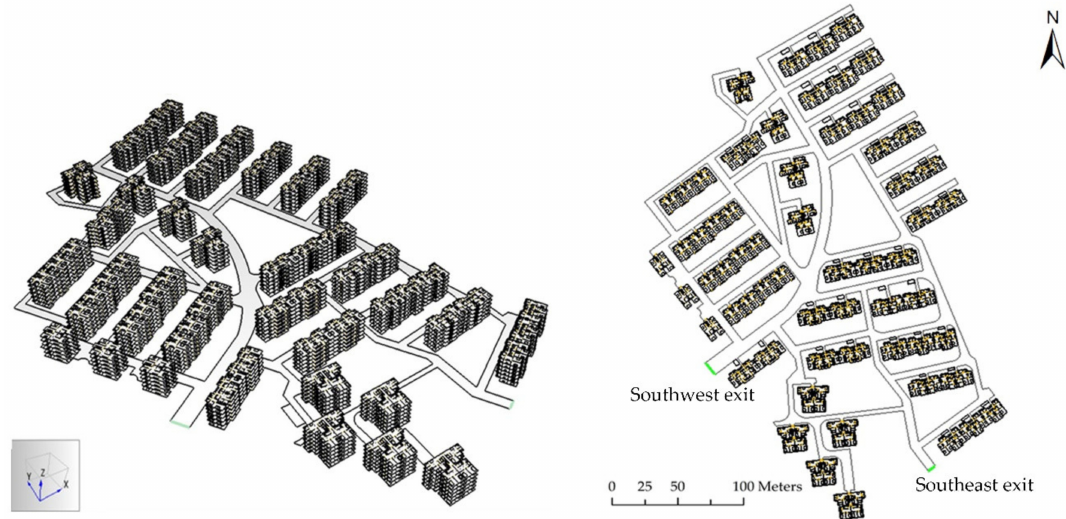
Figure 6. The oblique and plan view of the Luoshanqicun Community, Pudong New District, Shanghai,